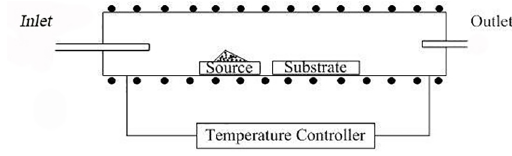
Figure 1. Air Pressure